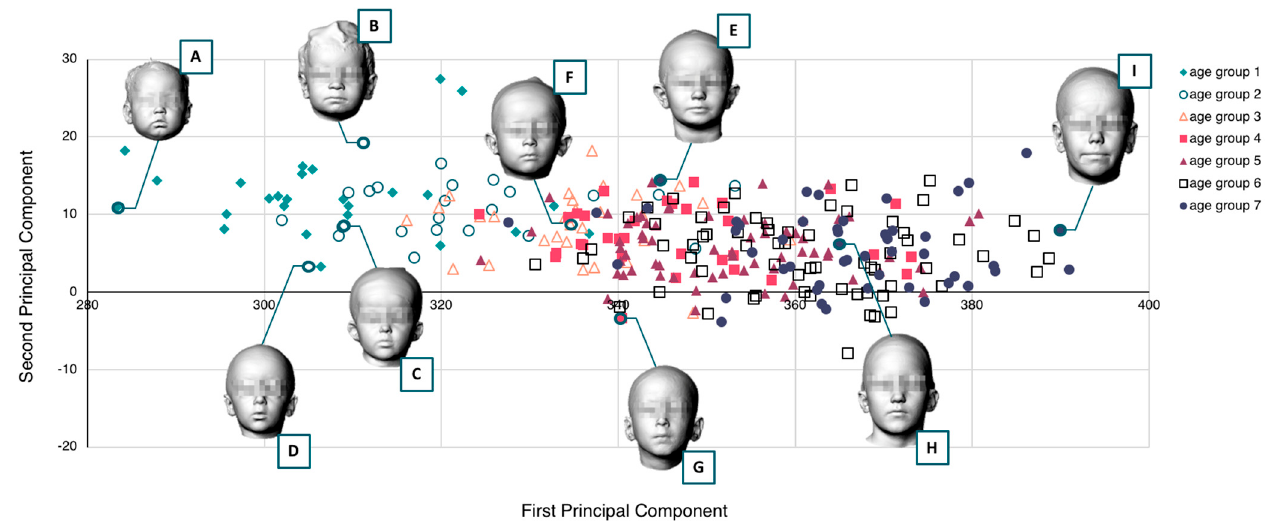
Figure 8. Scatterplot of the measurements based principal component scores including examples of different face shapes.